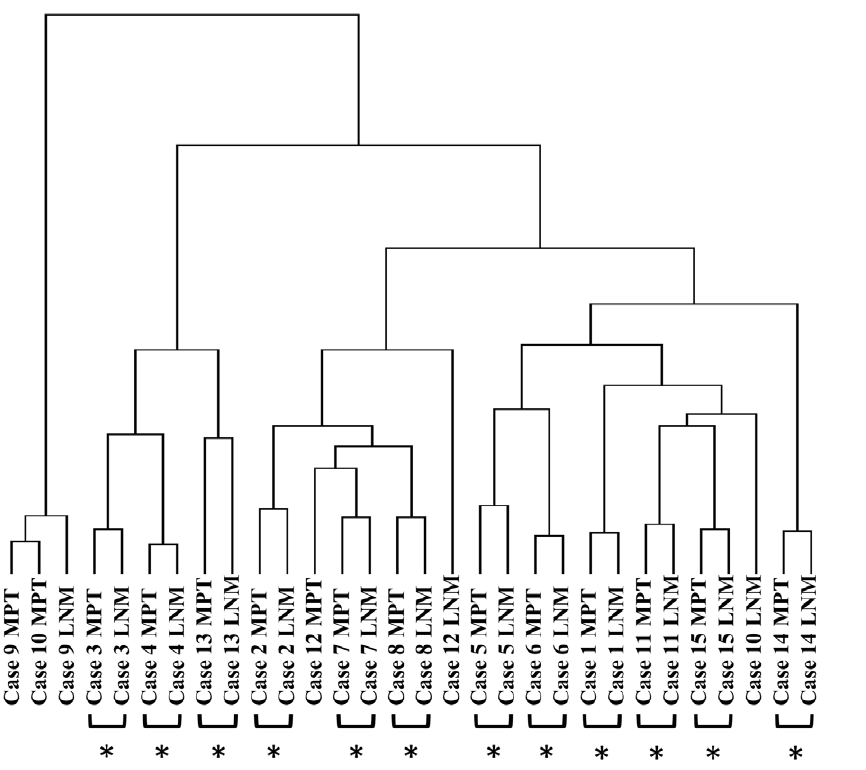
Figure 3. Unsupervised hierarchical clustering of genomic CNAs in MPT and LNM tumor samples from 15 patients. Unsupervised hierarchical clustering for the 30 tumor samples from 15 patients was performed based on the genomic CNAs. Twelve of 15 the MPT-LNM pairs were clustered together (indicated by asterisks).